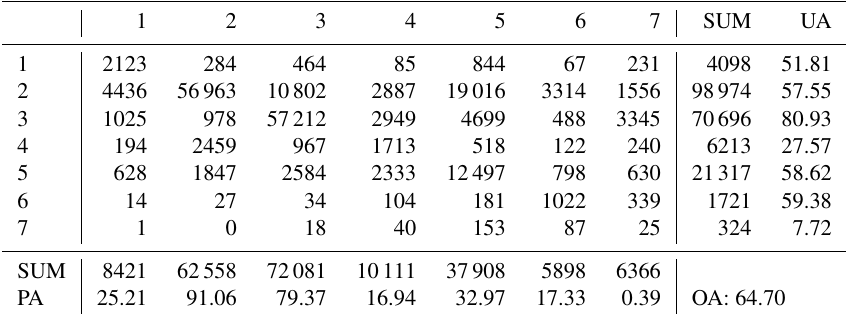
Table B6. Confusion matrix for LANDMATE PFT group 0.6 – the dominant LULC type occupies a minimum of 60% of a LANDMATE PFT grid